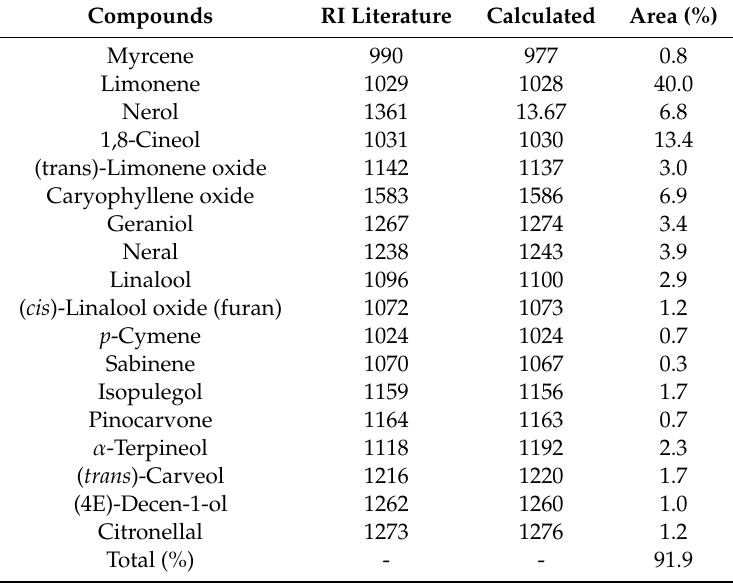
Table 1. Chemical composition of Citrus limonia OE using GC–MS [20]. Compounds RI Literature